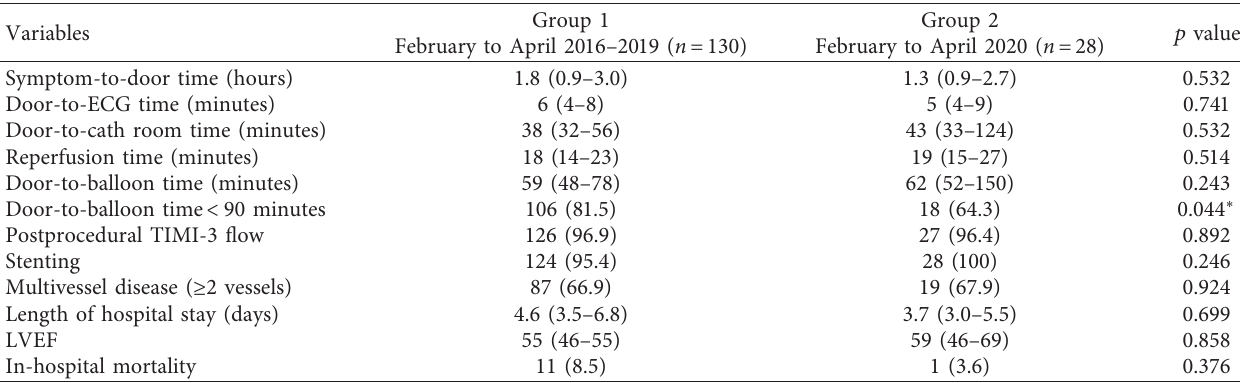
Table 2: Angiographic feature, results, and clinical outcomes.